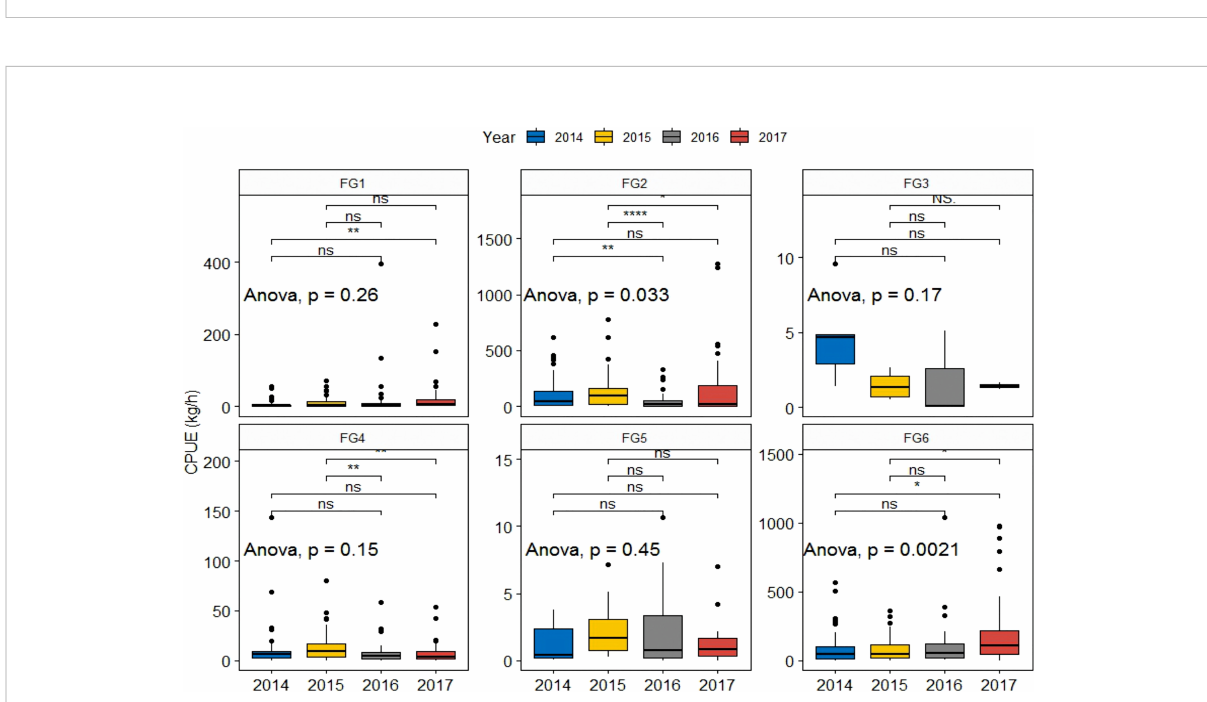
FIGURE 8 CPUE feeding functional groups for fi sh in the years before (2014 – 2014) and during (2016 – 2017) the MHWs. All pairs of groups were compared using the Kruskal – Wallis test for one-way ANOVA. * indicates signi fi cance at p<=0.05; ** indicates signi fi cance at p<=0.01; **** indicates signi fi cance at p<=0.0001; ns indicates no statistical signi fi cance.